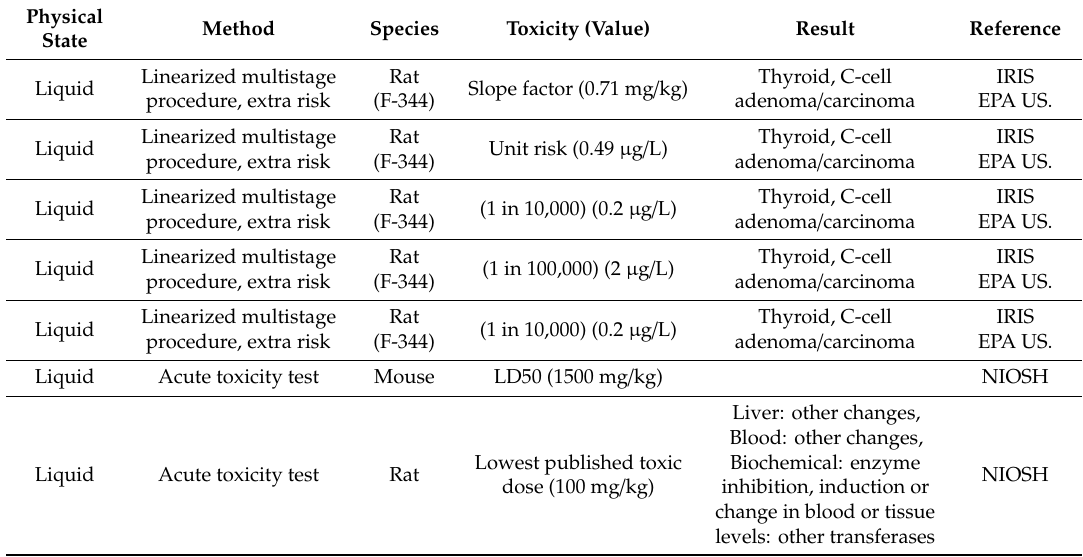
Table 2. Acute toxicity studies of benzyl